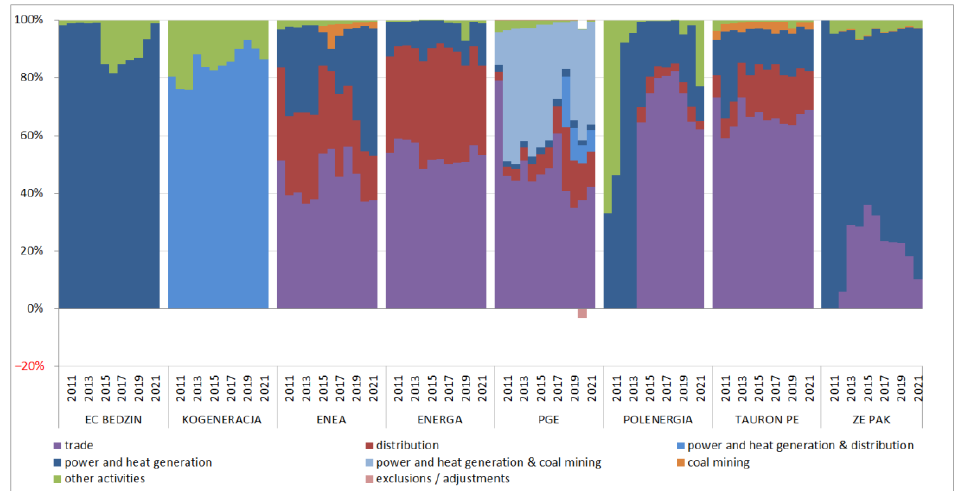
Figure 3. Structure of revenue from sales to external customers of the surveyed energy companies by business segment. Source: own elaboration.